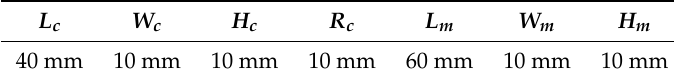
Figure 6. 6-DoF measurement structure and stator coordinate system. Table 1. Parameters of the magnet and